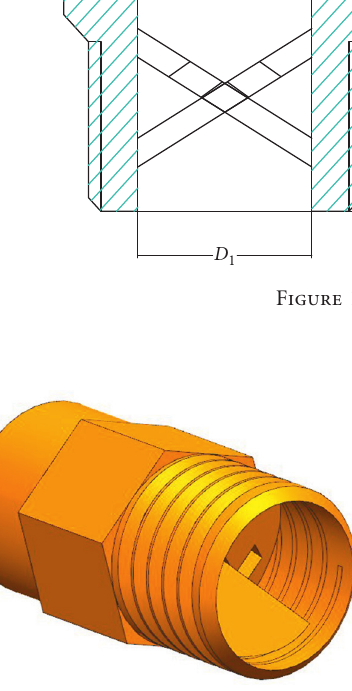
Figure 2: Space model of the swirl nozzle.